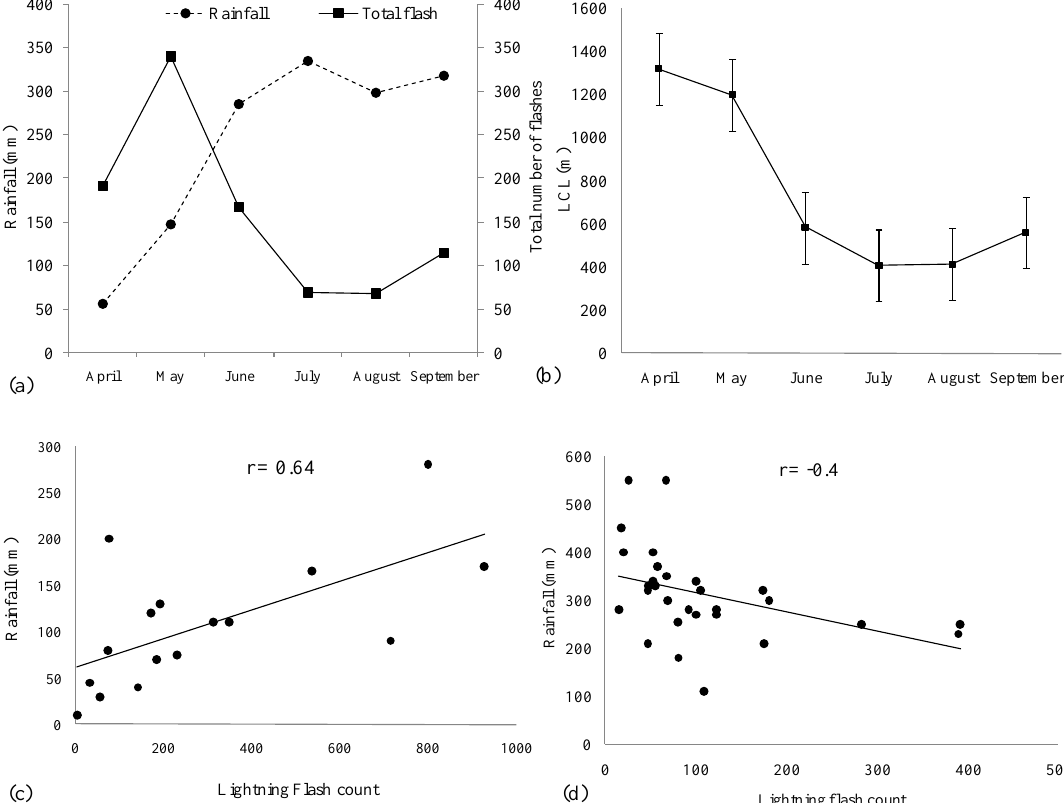
Figure 6. Comparison of rainfall and lightning flash count in view of LCL. ( a ) Variation of monthly average rainfall (mm) and average number of lightning flashes. ( b ) Lifting condensation level (LCL) over a meteorological station (Kolkata) in Gangetic West Bengal over the months (April to September) and Scatter diagram of lightning flash count and rainfall for ( c ) pre-monsoon (April–May) and ( d ) monsoon (June–September) periods from 2004 to 2011. Error bars represent first standard deviation of the parameter.